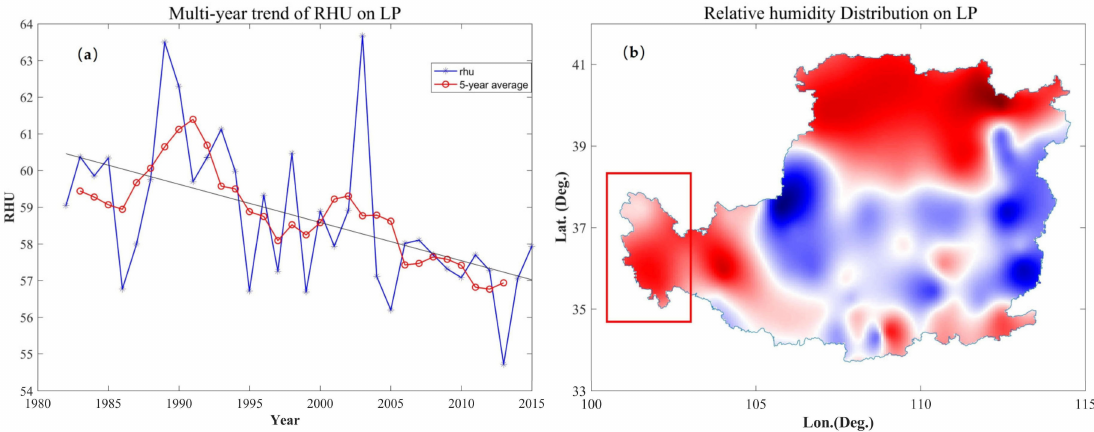
Figure 5. Time series of the average RHU ( a ) and spatial distribution over the Loess Plateau region ( b